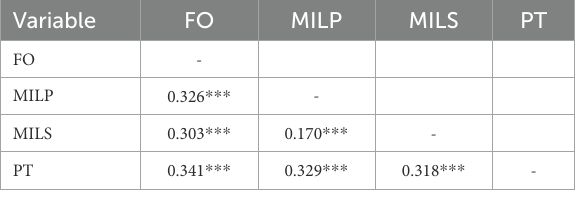
TABLE 3 Pearson’s correlation coefficient of the questionnaire measures.